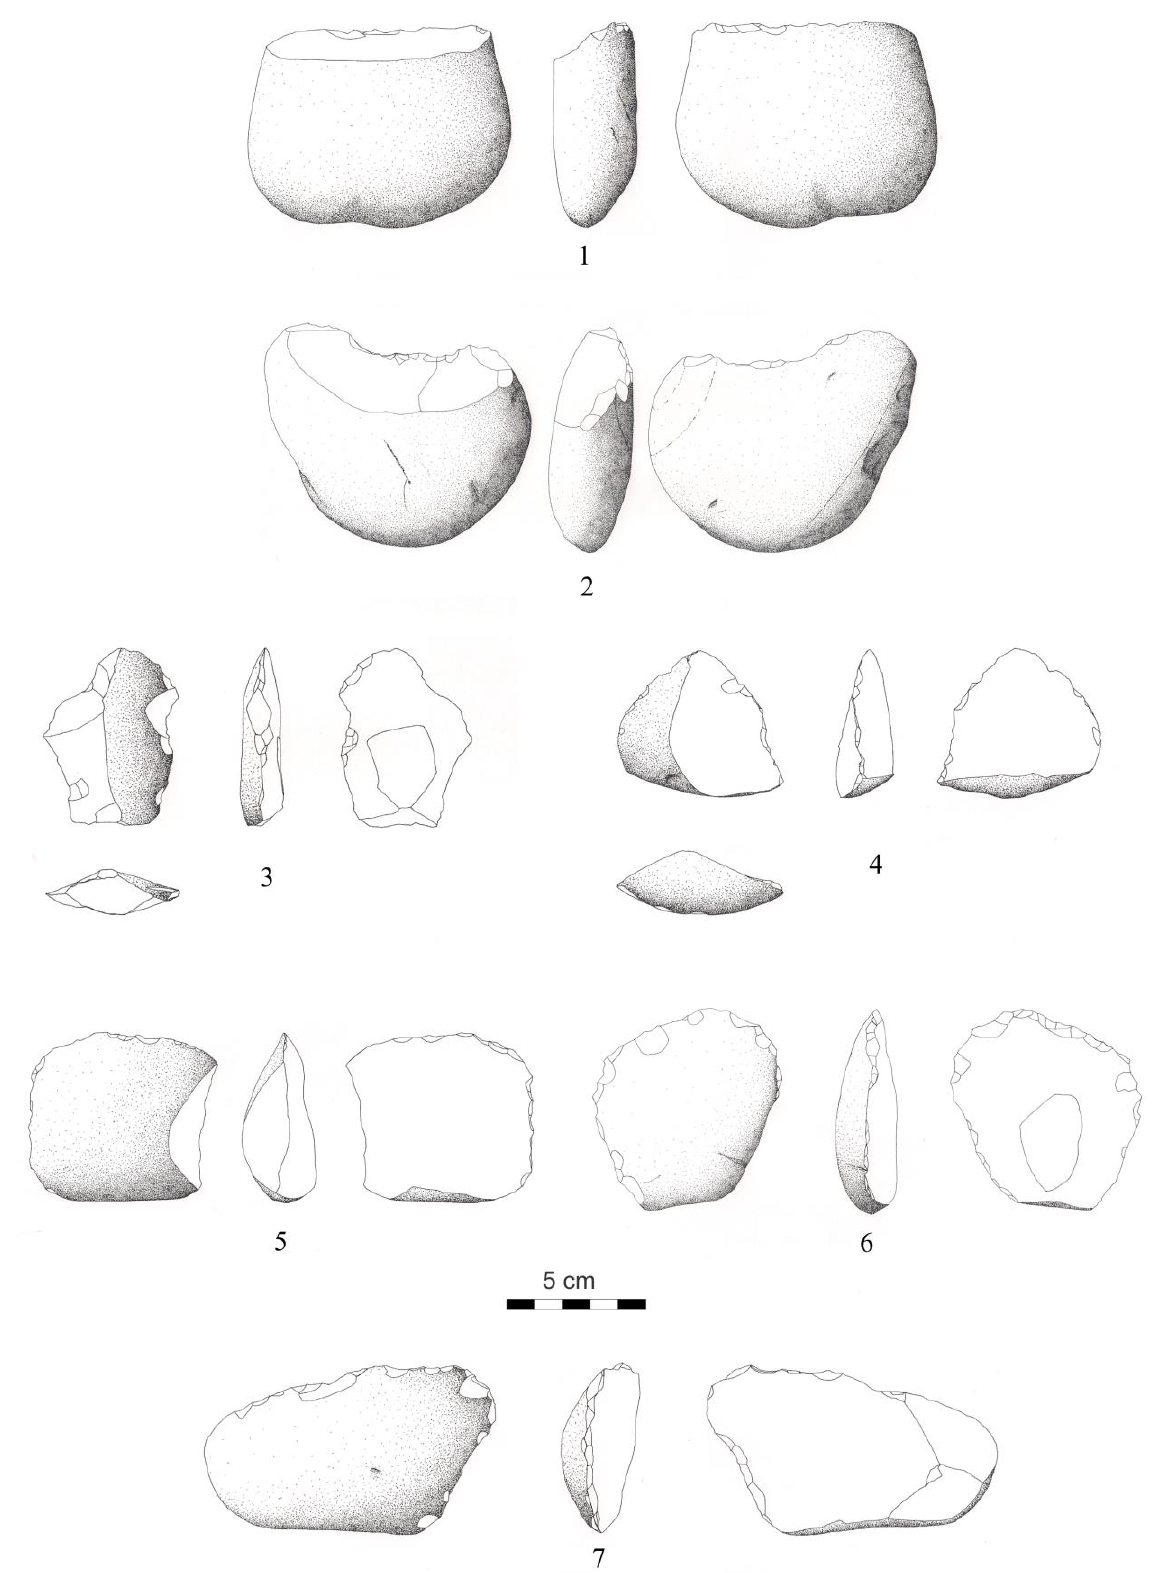
Figure 5. Lithic artifacts from RPP: 1 - Retouched pebble; 2 - Worked Pebble; 3 - Double notch on flake; 4-5 Retouched flakes; 6-7 - Informal retouched